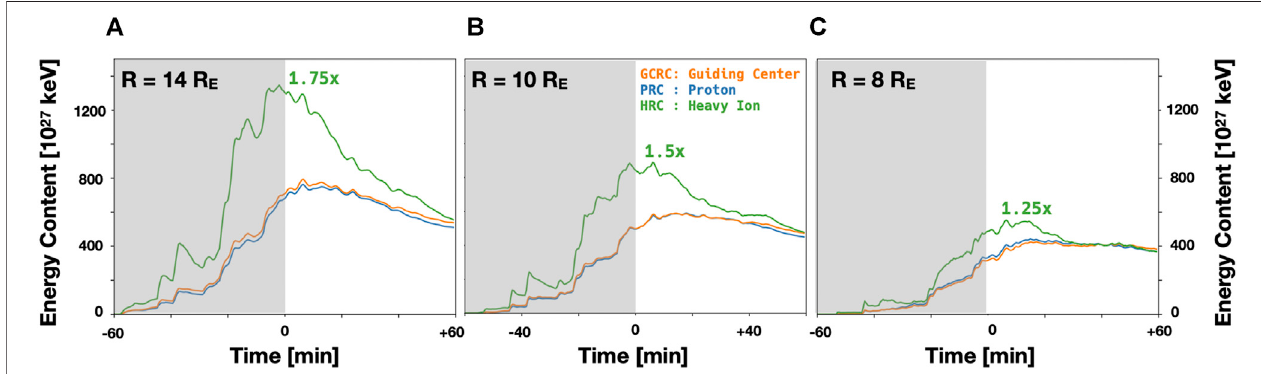
FIGURE 6 | Comparison of total energy content for identical test particle ensembles evolved with increasing gyroradius within equatorial radius R (cid:2) 14 (A) , R (cid:2) 10 (B) , and R (cid:2) 8 (C) . Shaded region denotes period where test particles are being actively injected into the nightside arc at R ≈ 18. Overlaid text is the approximate ratio of energy content at peak between HRC and